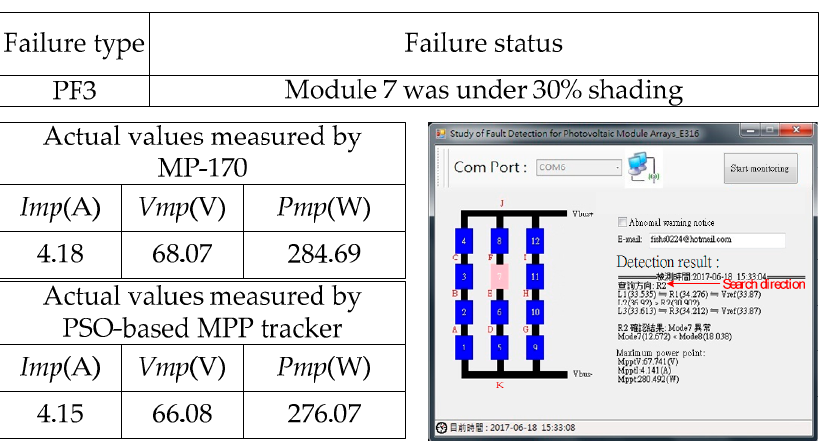
Figure 18. Experimental outcome for failure type PF3.